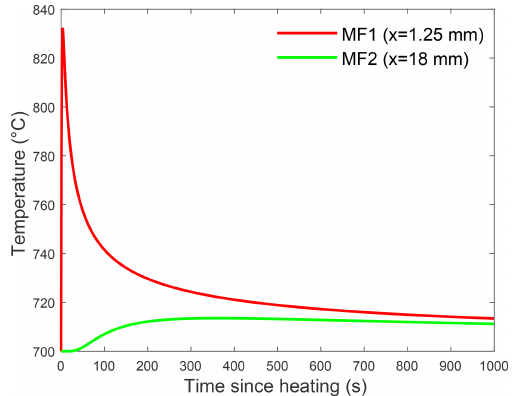
Figure 8. Results of the steady-state thermal diffusion model. The temperature at each microfracture is calculated relative to an am- bient eclogite facies temperature of 700 ◦ C over a timescale of 1000s after heating up to 1500 ◦ C along the fault surface. The heat is considered to first travel through the molten pseudotachy- lyte ( k = 0 . 72mm 2 /s) before diffusing through the wall rock ( k = 0 . 48mm 2 /s). Close to the pseudotachylyte, MF1 experienced a drastic temperature increase and steep cooling, whereas MF2 ex- perienced only a slight temperature increase. See Sects. 4 and 5 for